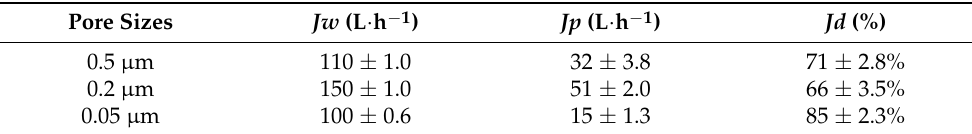
Table 7. Flux and pollution degrees of ceramic membranes ( n = 3), (0.1 MPa, 550 L · h − 1